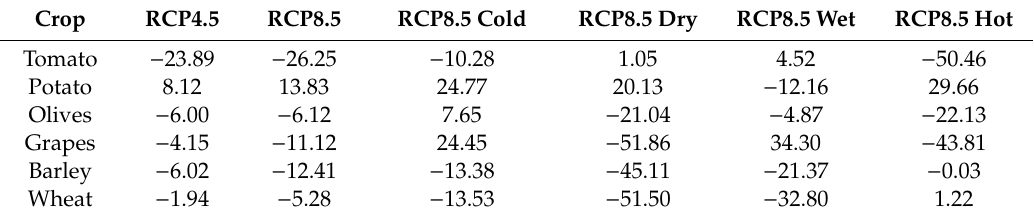
Table 9. Weighted average percentage yield change of the examined crops for the di ff erent climatic scenarios against the reference